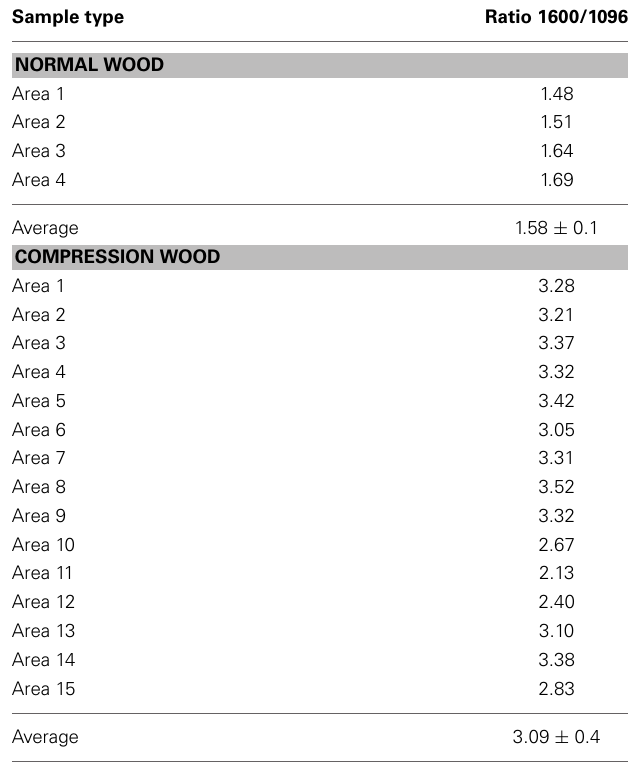
Table 2 | Lignin-to-cellulose ratio in normal and compression woods.